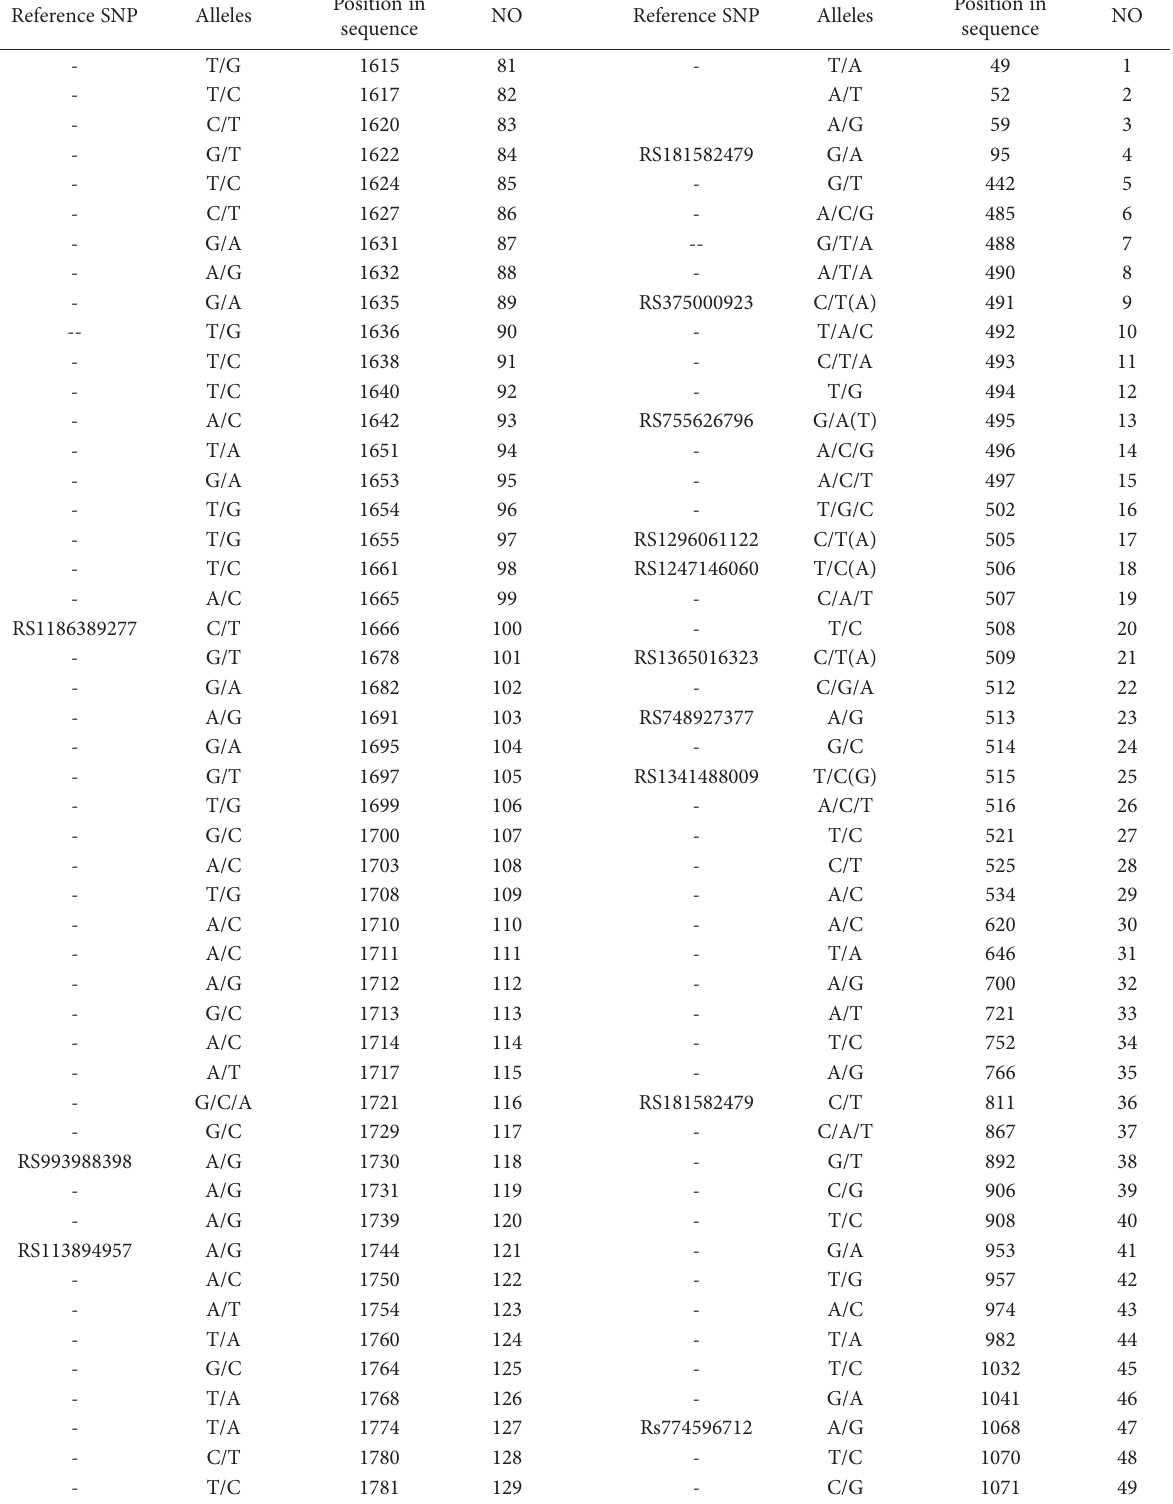
Table4. Details of SNPs/sequence polymorphism with TEXT-11 gene in the studied samples and